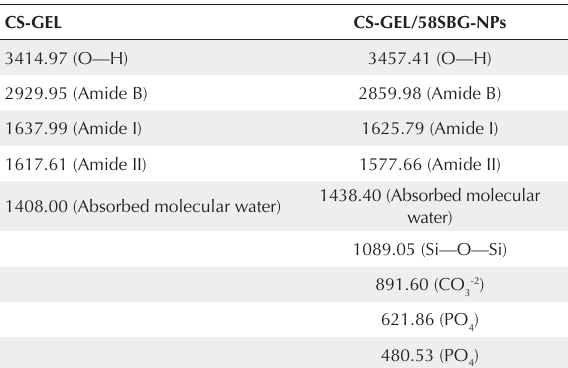
Table 1. Characteristic bands of CS-GEL and CS-GEL/58SBG-NPs scaffolds CS-GEL